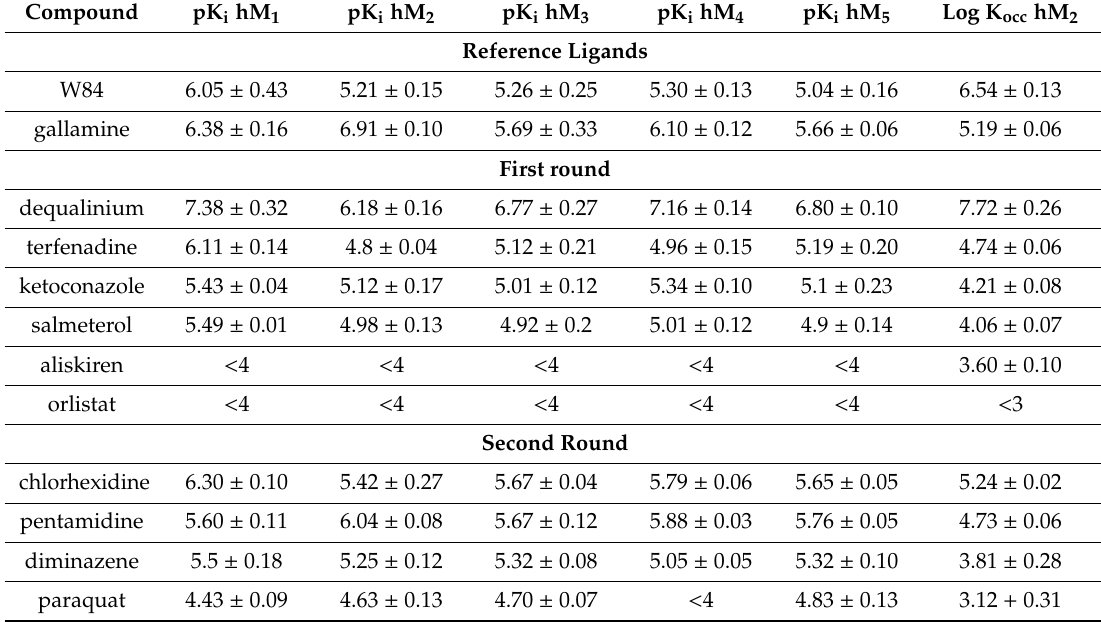
Table 4. Inhibition binding constants, pK i , describing estimated equilibrium binding a ffi nity for human cloned muscarinic receptors plus the a ffi nity estimates (log K occ ) at the [ 3 H]-NMS-occupied muscarinic hM 2 subtype. Values are reported as means of 3-4 experiments ±